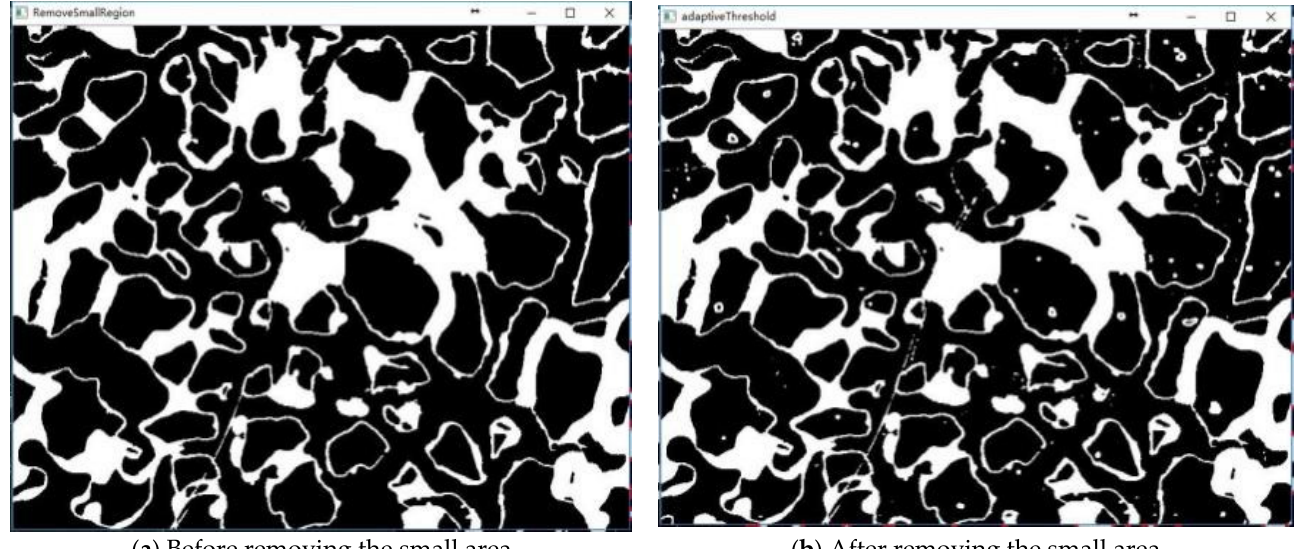
Figure 5. The effect map before and after removing the connected regions whose sum of the number of pixels is less than 300.